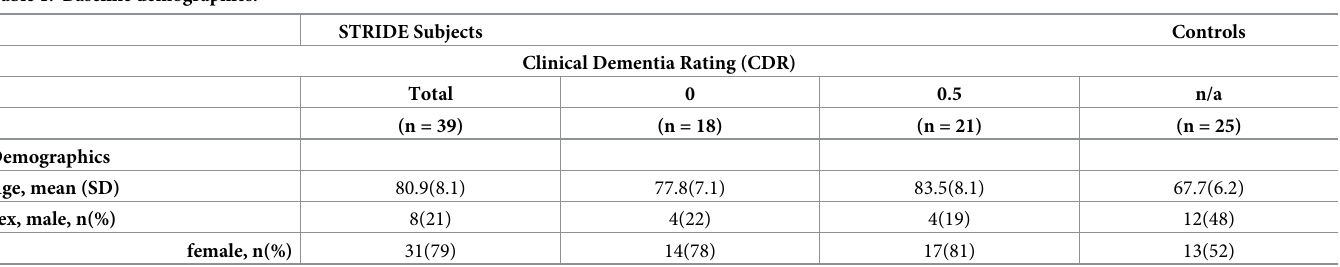
Table 1. Baseline demographics.